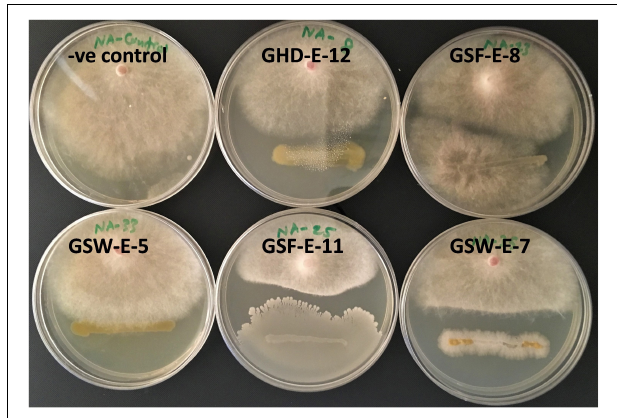
FIGURE 4 | Antifungal effect of halotolerant bacterial strains against F. culumorum in a dual culture assay.